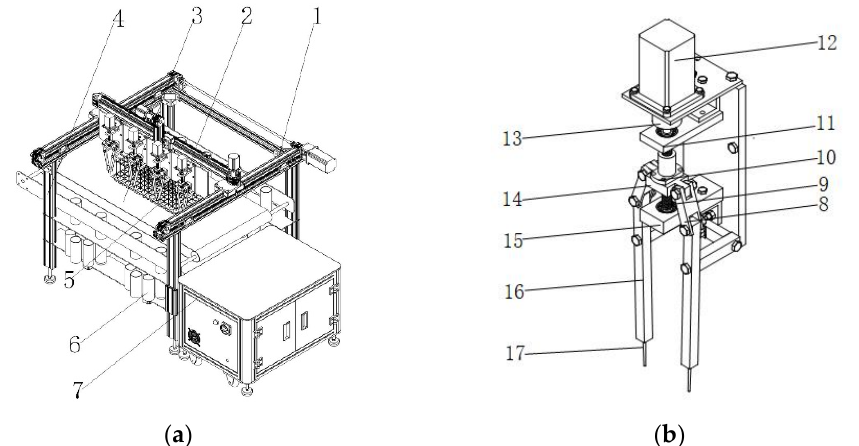
Figure 1. General and partial diagrams. ( a ) Overall construction of the seedling-picking device. ( b ) Seedling pick-up mechanism. (1) Translation module, (2) seedling-collection mechanism, (3) seedling tray conveyor belt, (4) frame, (5) bowl seedling tray, (6) connecting seedling cup, (7) control cabinet, (8) intermediate linkage, (9) screw, (10) screw nut, (11) upper bearing housing, (12) closed loop stepper motor, (13) coupling, (14) nut, (15) lower bearing housing, (16) swivel rod, and (17) seedling pin. Table 1. Parameters of step motor.